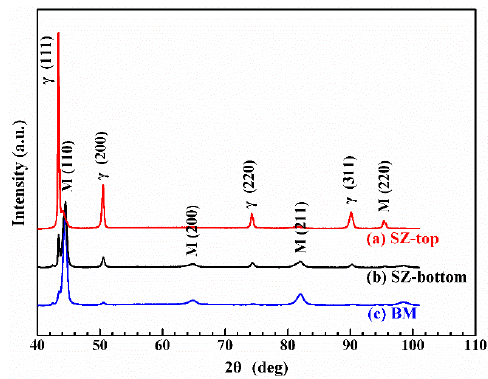
Figure 7. XRD profiles of welded sample: ( a ) SZ-top, ( b ) SZ-bottom, and ( c ) BM.